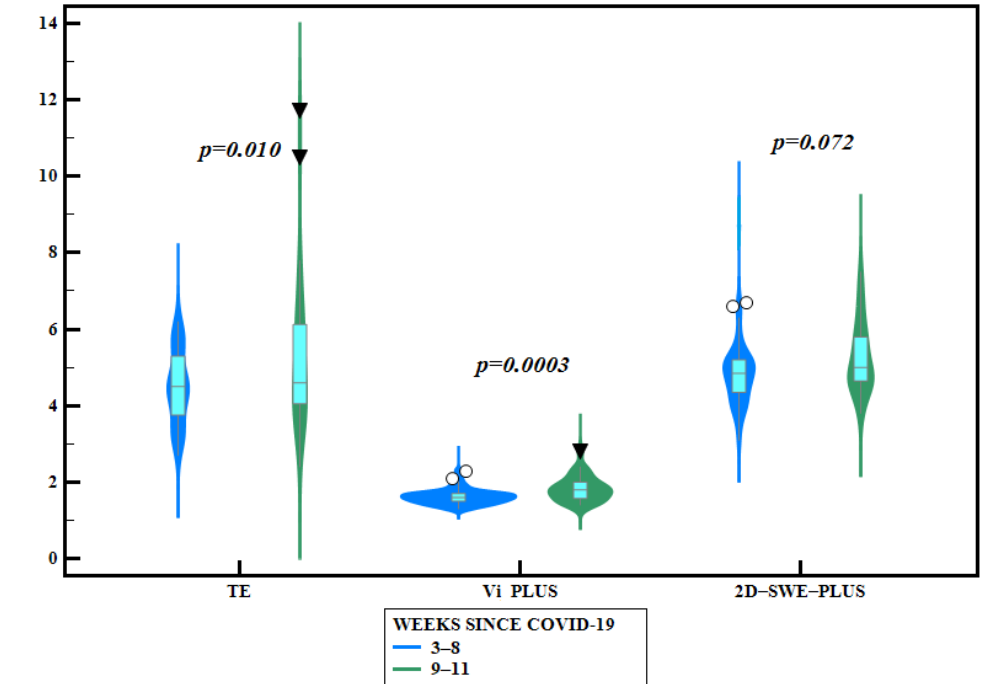
Figure 2. Violin plots comparing different liver elastography parameters according to the time elapsed after COVID-19 infection (blue outline plots = before 8 weeks since COVID-19 infection; green box plots = after 8 weeks since COVID-19 infection).